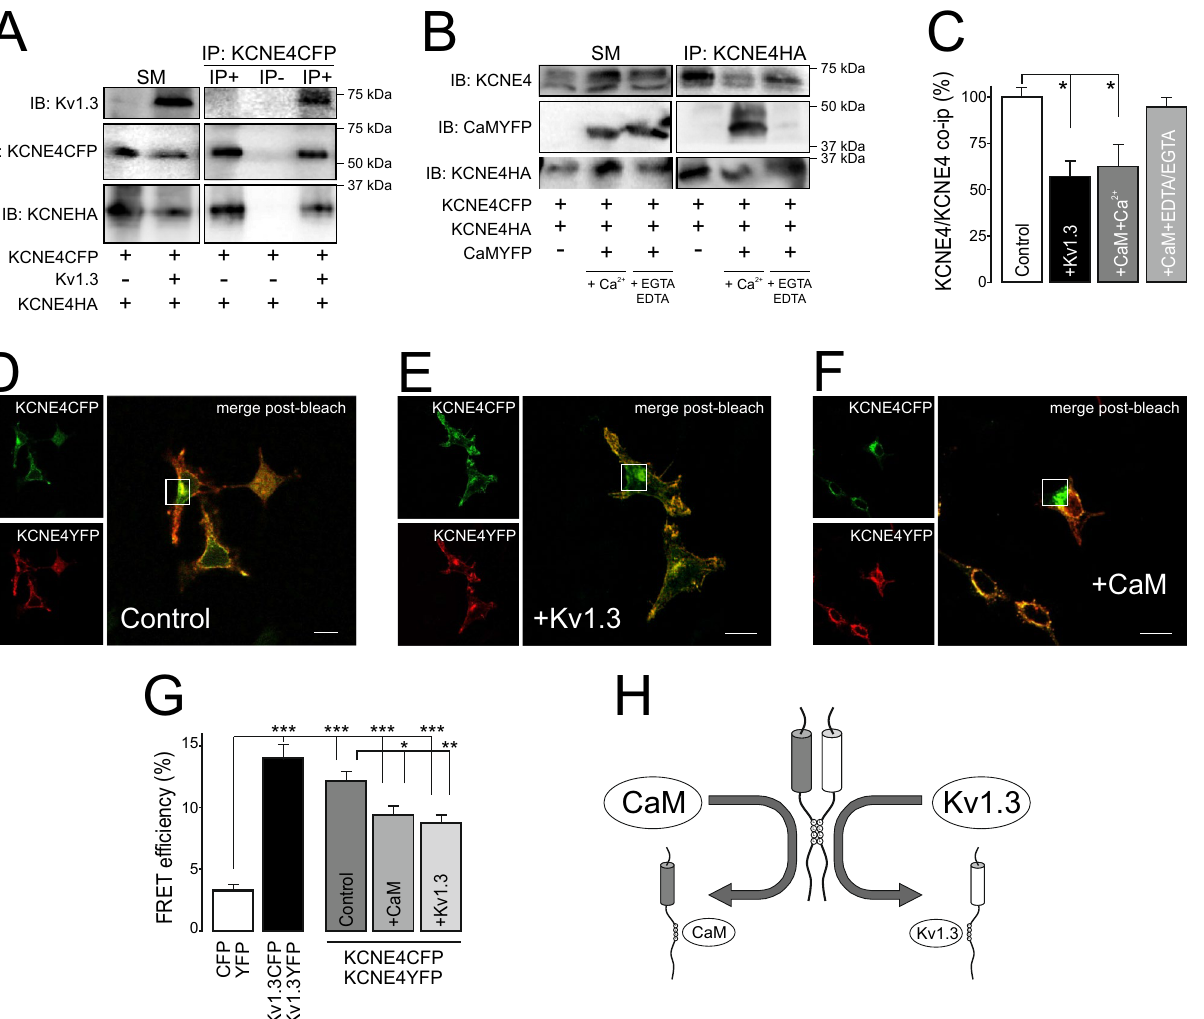
Figure 6. The presence of CaM and Kv1.3 impairs the dimerization of KCNE4. Coimmunoprecipitation of KCNE4-CFP and KCNE4-HA in the presence ( +) or absence (-) of Kv1.3 ( A ) and CaM ( B ). The experiment in the presence of CaM (+ CaM) was performed in the absence (+ 2 mM EDTA/2 mM EGTA) or the presence (+ Ca 2+ ) of 2 mM Ca 2+ . KCNE4 was immunoprecipitated (IP) with select anti-tag antibodies (anti-GFP and anti-HA), and membranes were blotted (IB) against Kv1.3, KCNE4 and CaM with the indicated primary antibodies (anti-Kv1.3, anti-KCNE4, anti-GFP or anti-HA). Representative cropped blots are clearly separated by vertical white lines. ( C ) Relative KCNE4/KCNE4 coimmunoprecipitation in the presence of Kv1.3 and CaM. Control represents KCNE4/KCNE4 with no additions. The values represent the mean of 4 independent experiments. * p < 0.05 vs control (KCNE4-CFP/KCNE4-HA in the absence of further additions, Student’s t -test). ( D–F ) Representative FRET experiments between KCNE4YFP and KCNE4CFP in the absence (D, control) or presence of + Kv1.3 ( E ) or + CaM ( F ). Green panels, KCNE4-CFP (donor); red panels, KCNE4-YFP (acceptor); merged postbleach panels; yellow indicates colocalization; white square highlights the acceptor photobleached ROI analyzed. Bars represent 10 μm. ( G ) FRET efficiency quantification of KCNE4-CFP/KCNE4-YFP in the presence of CaM and Kv1.3. The values represent the mean of 20–30 cells. * p < 0.05; ** p < 0.01; *** p < 0.001 (Student’s t -test). Control, no additions; + CaM, presence of CaM; + Kv1.3, presence of Kv1.3. CFP/YFP, negative controls; Kv1.3YFP/Kv1.3CFP, positive controls. ( H ) Schematic showing the interfering associations impairing KCNE4 dimer formation due to multiple tetraleucine motif interactions. The presence of either CaM or Kv1.3 would disrupt KCNE4 association, inhibiting dimer